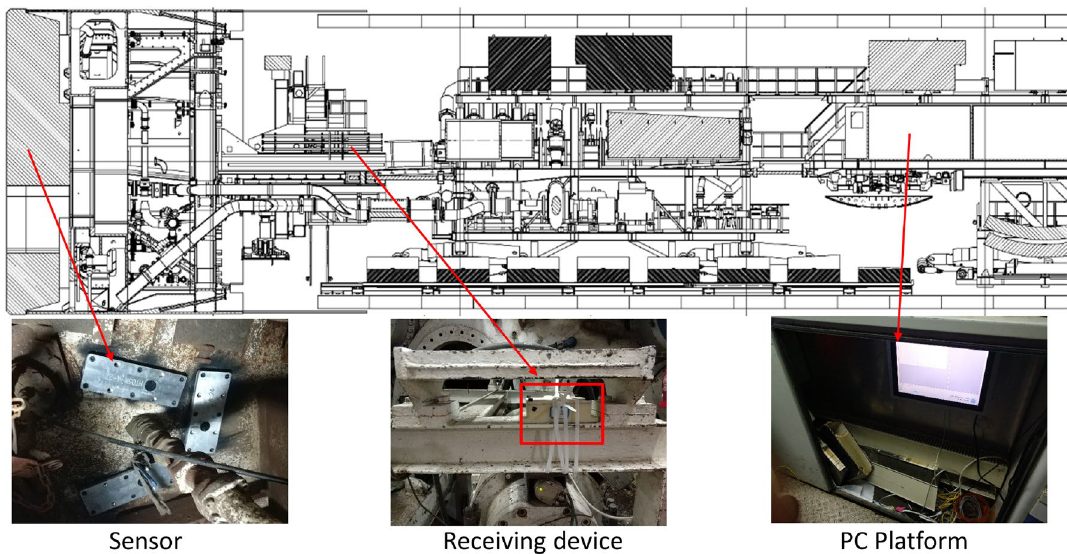
Figure 9. Installation position of monitoring system (Generated by Auto CAD 2010 and Microsoft PowerPoints